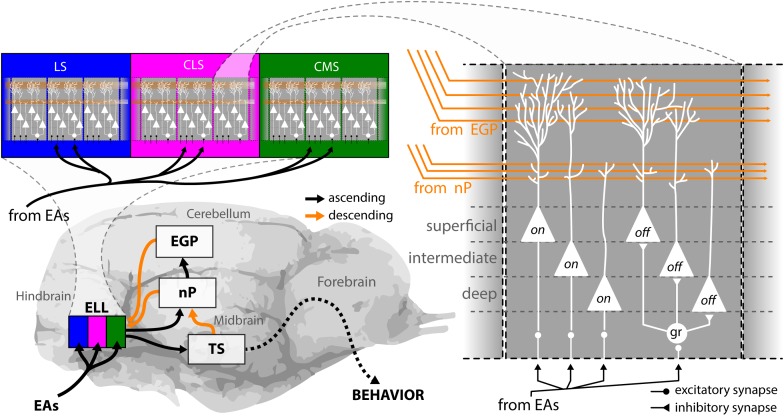
Anatomy of the electrosensory pathway. EOD AMs are detected by electroreceptors distributed in the fish’s skin, from where they send EAs to the electrosensory lateral line lobe (ELL) in the hindbrain (bottom left). The ELL is a cerebellum like structure with ascending (black arrows) and descending (orange arrows) projections and is organized in three parallel segments, the lateral (blue), the centro-lateral (magenta), and the centro-medial (green) segments (top left). The body surface is represented somatotopically in each segment. Moreover, pyramidal cells within all segments are arranged in a columnar organization with every column consisting of six cells (right). Three of these are on-type, as they receive direct excitatory input from EAs through basal dendrites therefore responding with an increase in firing rate to increases in EOD amplitude. The other three cells are Off-type, as they receive afferent signals via inhibitory interneurons (gr) and thus respond with a decrease in firing rate to increases in EOD amplitude. For each neuron type (i.e., On or Off), there is one superficial, one intermediate and one deep cell to be found within every ELL column. These differ in the amount of descending inputs they receive. Pyramidal neurons are the output neurons of the ELL that project to the midbrain torus semicircularis from where signals are processed and relayed to higher order brain areas to ultimately generate behavioral output. All pyramidal neurons receive descending inputs that originate from midbrain projections to the nucleus praeminentialis (nP) and projects in a somatotopically ordered fashion to the ELL (direct pathway). In addition, superficial and intermediate pyramidal neurons receive indirect descending inputs from the eminentia granularis posterior (EGP) onto their large apical dendritic arborizations in a spatially diffuse manner (indirect pathway). These inputs originate from the outputs of deep pyramidal neurons to EGP indirectly through nP. Descending inputs to ELL are excitatory via direct synapses between parallel fibers and apical dendrites and inhibitory through local interneurons in the molecular layer (not shown). EAs, electrosensory afferents; CLS, centrolateral segment; CMS, centromedial segment; EGP, eminentia granularis posterior; ELL, electrosensory lateral line lobe; gr, granule cell; LS, lateral segment; nP, nucleus praeminentialis.